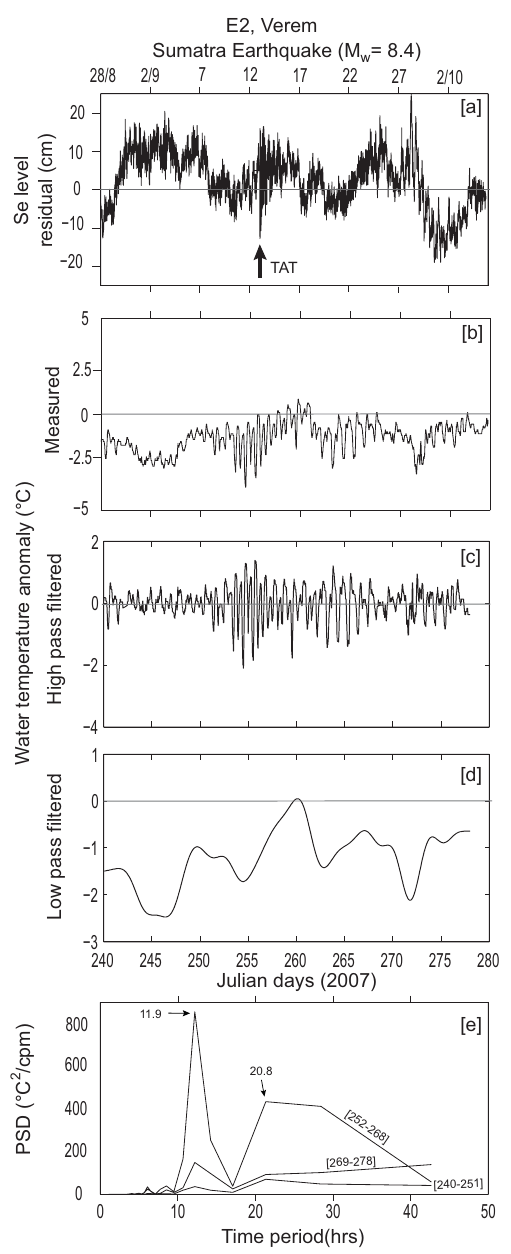
Fig. 3. Sea water parameters observed at Verem, Goa in response to the episodic event E2 of 12 September 2007 due to Sumatra earth- quake ( M w =8.4). (a) sea-level residual (cm), (b) measured water temperature anomaly ( ◦ C), (c) high pass filtered water temperature anomaly ( ◦ C), (d) low pass filtered water temperature anomaly ( ◦ C) and (e) spectrum of measured water temperature anomaly before (Julian days 240–251), during (Julian days 252–268) and after (Ju- lian days 269–278) the tsunami arrival time (TAT) at Verem. The TAT at Goa was 00:45IST on 13 September 2007. The number associated with significant peaks is time period in hours.